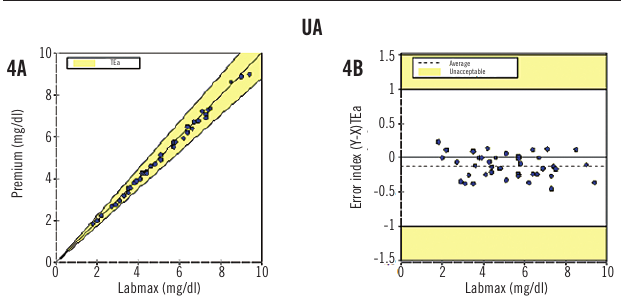
figurE 2 − Comparisons between AST measurement for 2 automated chemistry platforms A) linear regression for AST measurements between instruments Labmax 240 ® (E1) and Labmax 240 Premium ® (E2): n = 40, r = 0.989; p < 0.05; equation for the correlation: E2 = 1.045*E1 - 0.6; TEa = 16.7%; B) graph comparing the systems Labmax 240 ® (E1) and Labmax 240 Premium ® (E2) for AST measurement: error index = [(result - mean)/TEa]